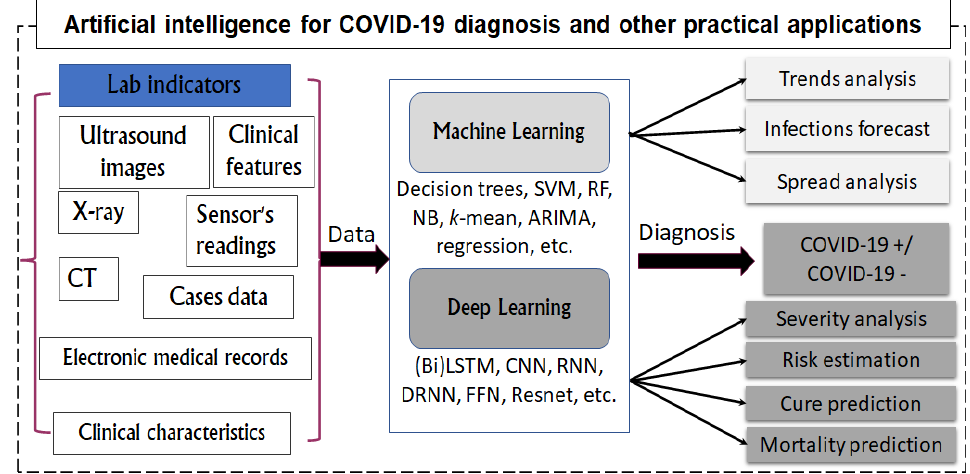
Figure 6. Overview of AI models application to heterogeneous data in the context of COVID-19. Table 3. Summary of promising applications of AI in the era of